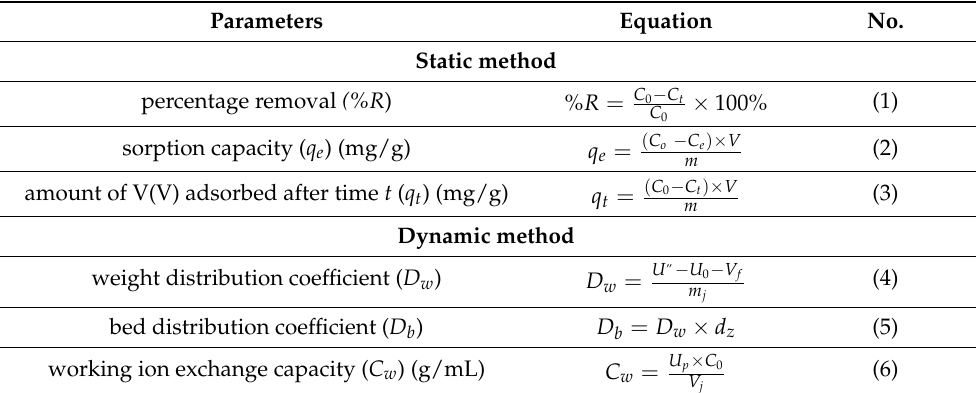
Table 2. Adsorption efficiency determination by static and dynamic